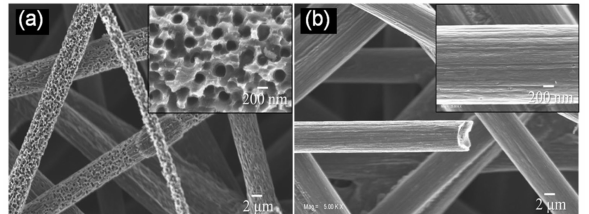
Figure 15. SEM images showing ( a ) VO 2 nanoporous structure grown on carbon fibers (The inset at upper right corner reveals the pore diameter around 200 nm.), ( b ) uncoated carbon fibers (The inset at upper right corner reveals the relatively smooth fiber surface.). Reproduced under the terms and conditions of the liberal Creative Commons Attribution 4.0 International (CC BY) license from [108]. Published by Springer Nature. Copyright © 2019 The Authors.